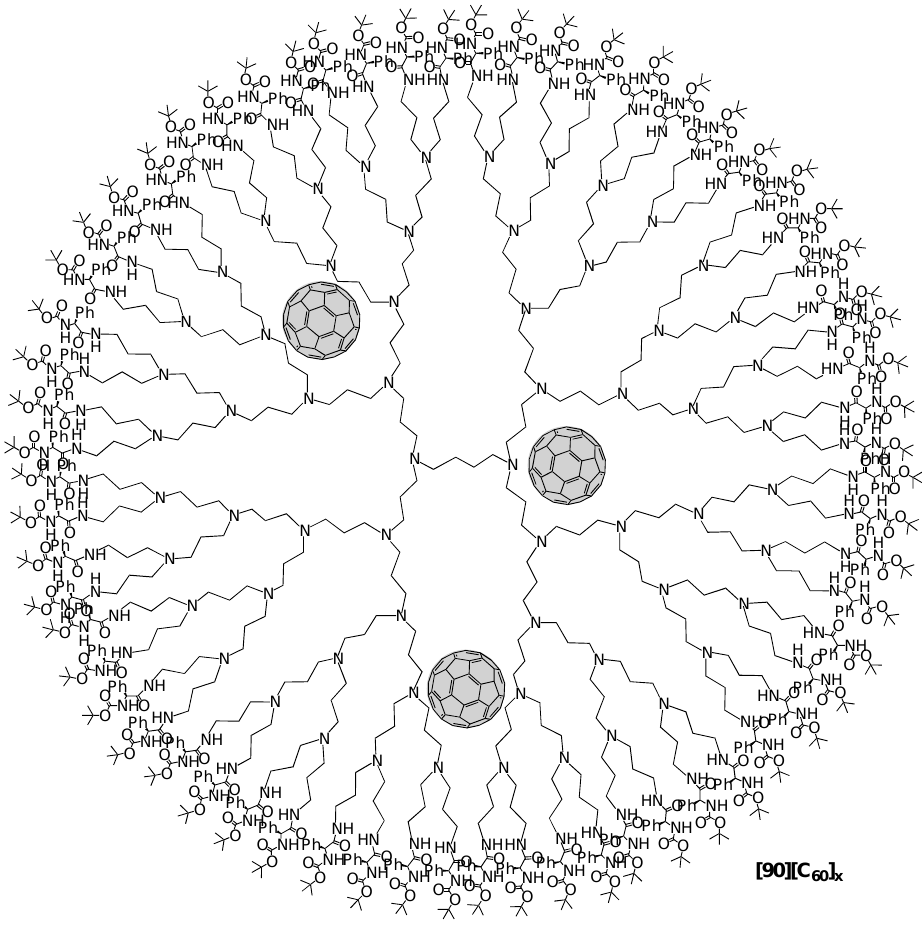
Figure 17. Schematic representation of encapsulated fullerene moieties within the backbone of a POPAM G5 dendrimer according to Márquez et al